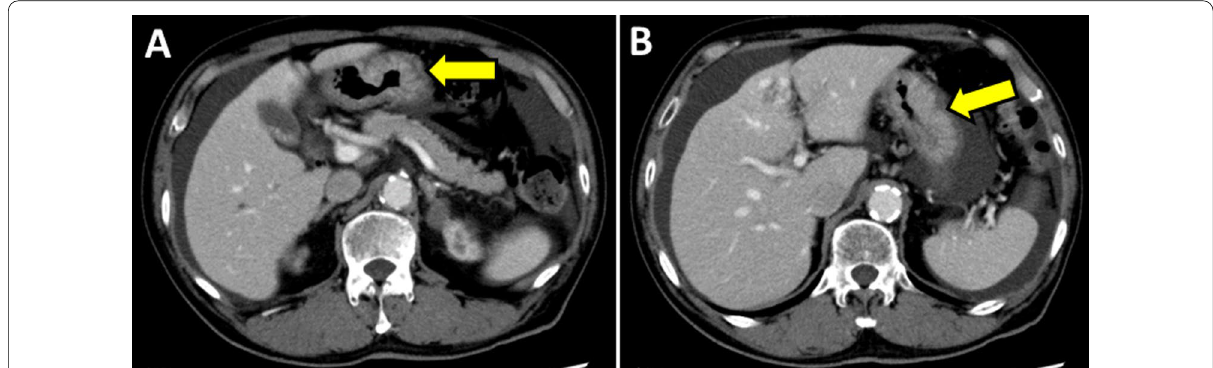
Fig. 1 Computed tomography scan. Yellow arrows show the gastric wall thickness in the lower gastric body. A Gastric cancer, B